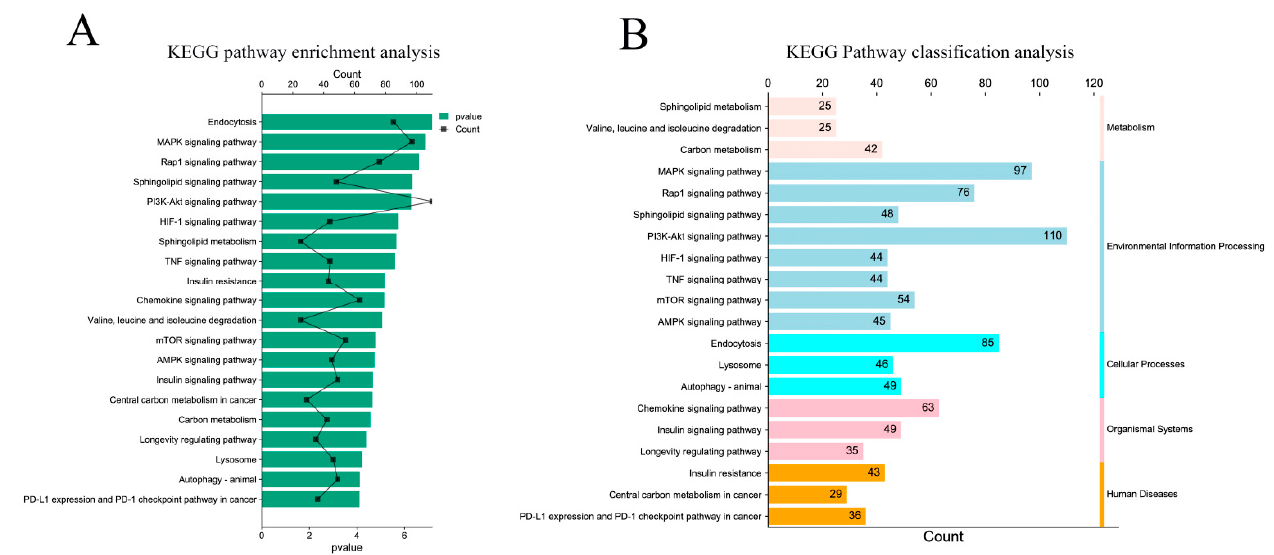
Figure 5. KEGG pathway enrichment analysis of target genes. ( A ) Significantly enriched KEGG pathway with target genes of DE miRNAs; ( B ) classification of significantly enriched KEGG pathways.